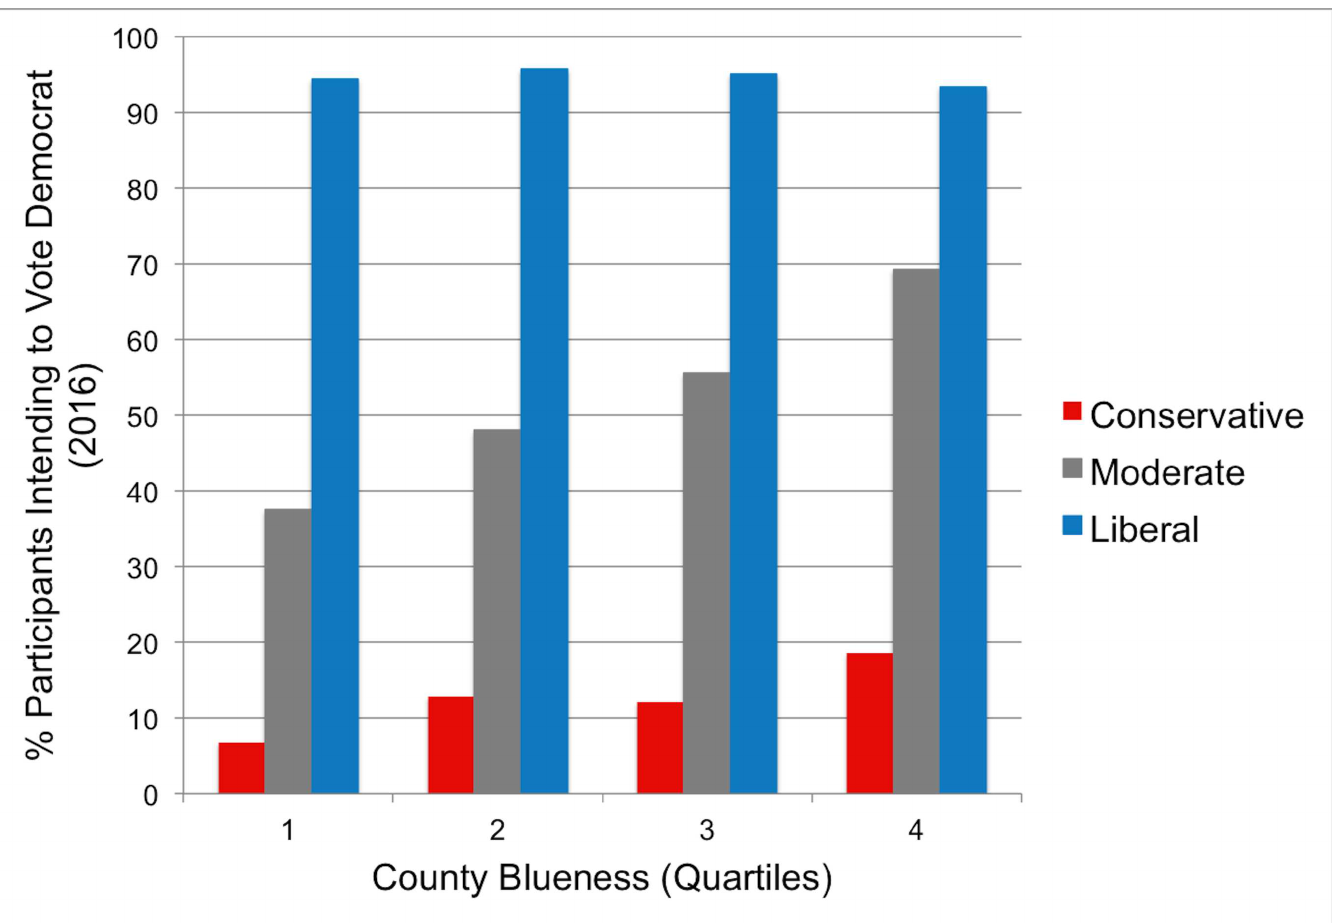
Fig 3. Voting intentions by county blueness for each political identity category. County blueness is dividedinto quartilesfor visualizationpurposes, but was treated as a continuousvariablein all analyses. If politicalideologyhad the same meaningregardlessof locationall bars of the same color would be the same